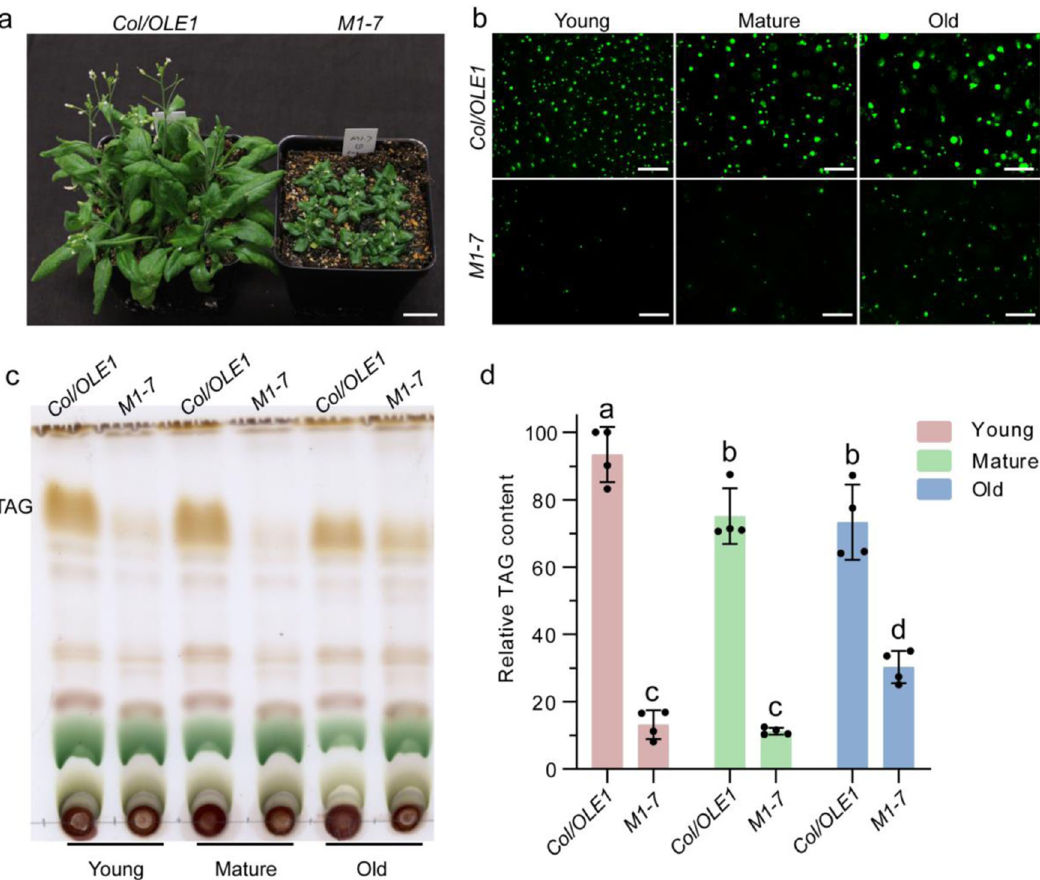
Fig. 1 TAG content and LD abundance are dramatically decreased in M1-7 mutant. a Phenotypes of 4-week-old M1-7 and Col/OLE1 . Bar = 2 cm. b Representative images of LDs (OLE1-GFP, green) in rosette leaves of different ages of 4-week-old plants (young leaves: the upper growing leaves; mature leaves: the newest expanded leaves; old leaves: the oldest expanded green leaves). The experiment was repeated 5 times with similar results. Bar = 50 μ m. c Thin-layer chromatogram of neutral lipids in leaves of M1-7 and Col/OLE1 . Lipids were visualized with 5% sulfuric acid by charring. d Relative TAG contents in leaf of M1-7 and Col/OLE1 quanti fi ed by Image J software. Data are mean ± SD. of four biological replicates. Different letters indicate signi fi cant differences at P < 0.05, as determined by one-way ANOVA with Tukey ’ s multiple comparisons